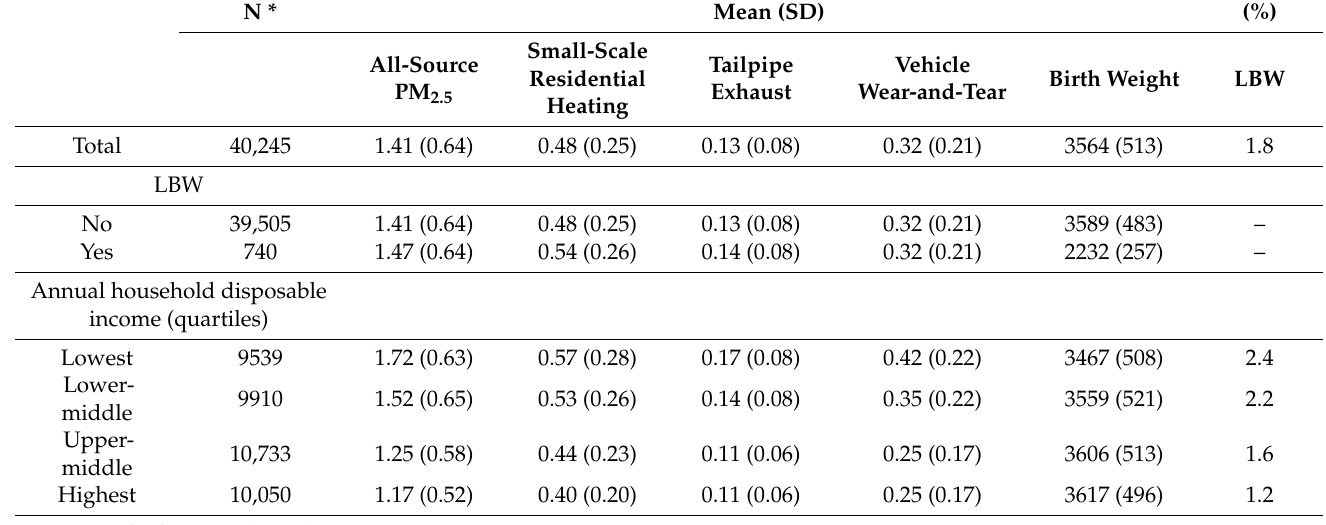
Table 1. Mean and standard deviation (SD) of local PM 2.5 concentrations ( µ g/m 3 ) during pregnancy, for birth weight, low birth weight (LBW; <2500 g), and different covariate categories, for children with and without LBW and totally. This table is based on the 40,245 study subjects for whom data on all-source PM 2.5 was